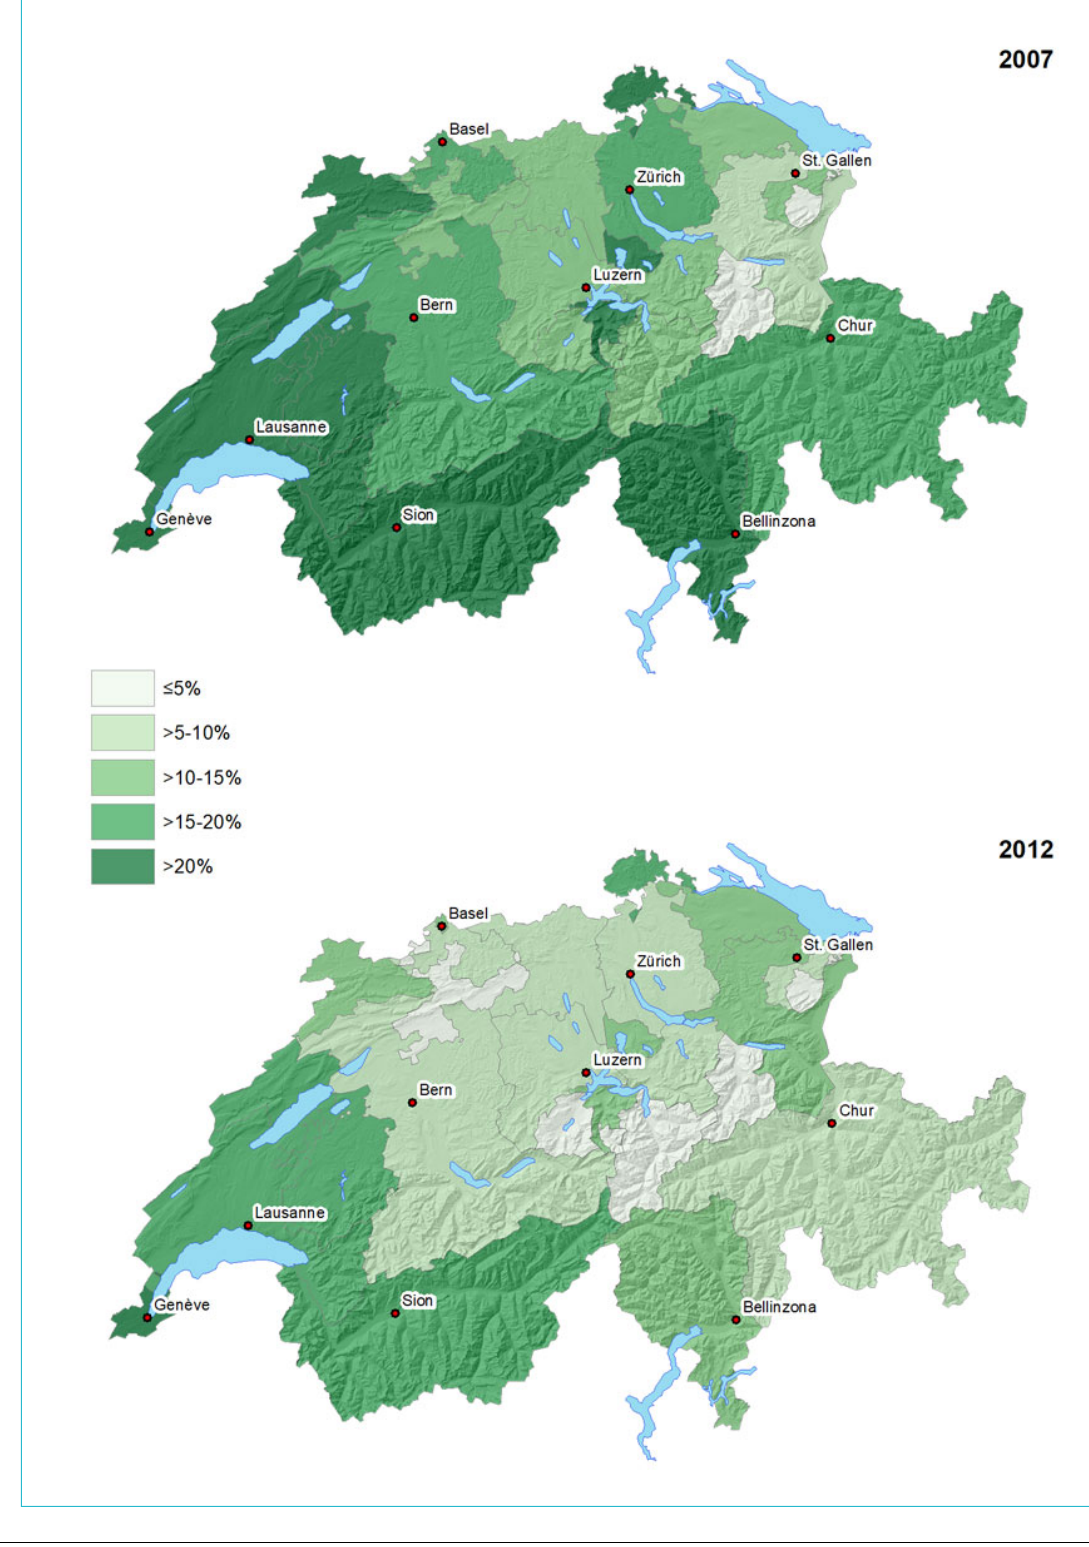
Figure 1: Geographical distribution of self-reported mammography in the last 12 months (percentage of population) in women aged 40-79 years in Switzerland, 2007 and